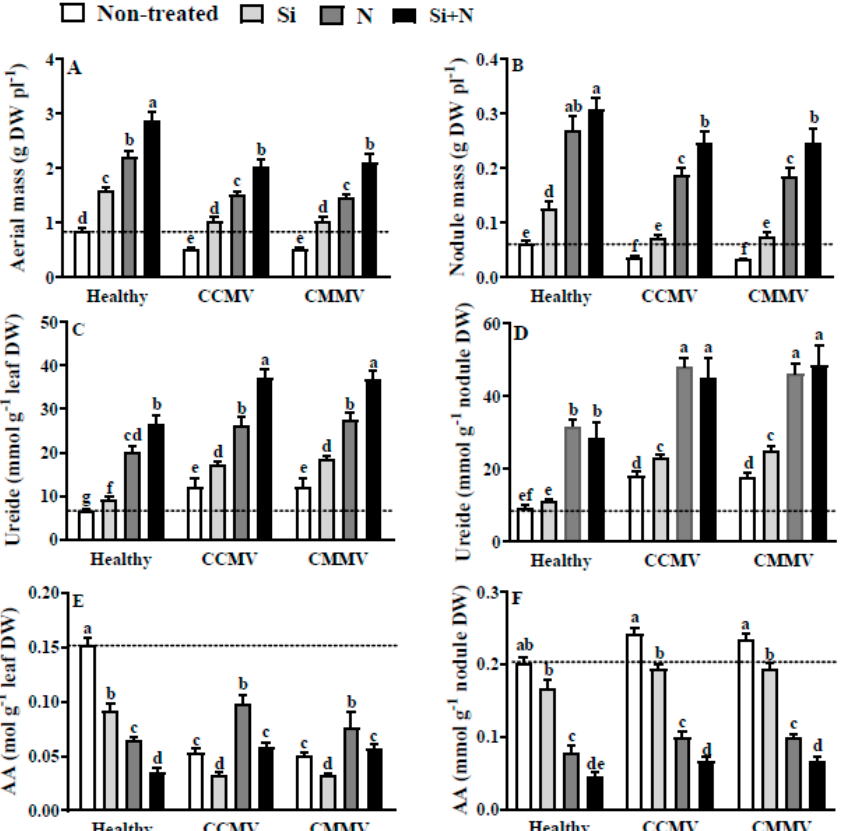
Figure 3. Effects of 2 mM silicic acid (Si), 10 mM KNO 3 (N) and the combination of Si + N on the aerial mass ( A ), nodule mass ( B ), ureide content in the leaves ( C ) and nodules ( D ), and amino acids (AA) content in the leaves ( E ) and nodules ( F ) of healthy and Cowpea chlorotic mottle virus (CCMV) or Cowpea mild mottle virus (CMMV)-infected 30-days old mung bean ( V. radiata ). Dotted line serves as reference to value of healthy non-treated control. Means of six replicates ( ± SE) in bars labeled with the same letter(s) are not significantly different (LSD, p < 0.05).